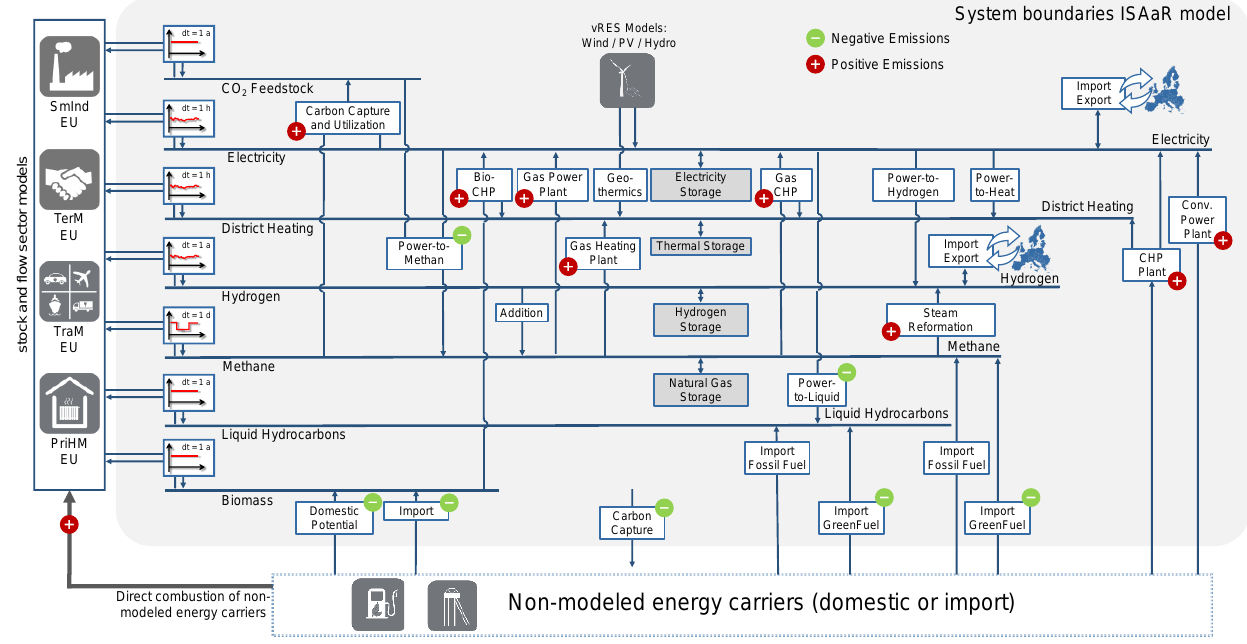
Figure 1. Model landscape and model interconnection as well as generation and sector coupling technologies in ISAaR. Own figure based on [11,28,30].